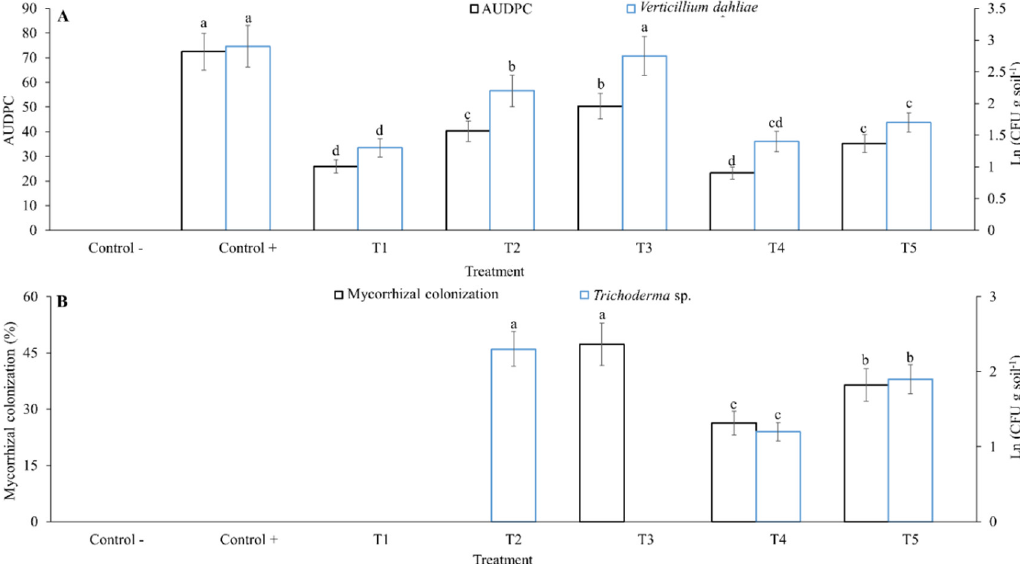
Figure 3. Effect of management practices of Verticillium dahliae in Hass avocado under net-house conditions on beneficial population of soil microorganism and reduction of AUDPC. ( A ): area under disease progress curve (AUDPC) of wilt disease under different treatments. ( B ): mycorrhizal colonization and inoculum of Trichoderma sp. quantified under different treatments for wilt disease. Error bars represent the confidence interval of the mean, validated by Tukey mean separation test. Equal letters indicate that there are no significant differences ( p > 0.05). Treatments were (where “nh” stands for net-house conditions): a non-inoculated control of healthy plants (nh—healthy control); a control of plants inoculated with V . dahliae (Vert 2) (nh—diseased control); T1nh (fungicide): Verticillium -inoculated plants + benomyl; T2nh (Tricho- derma): Verticillium -inoculated plants + inoculation with Trichoderma sp.; T3nh (mycorrhiza): Verticillium -inoculated plants + inoculation with R . fasciculatum ; T4nh (fungicide-Trichoderma-mycorrhiza): Verticillium -inoculated plants + simultane- ous application of T1nh+T2nh+T3nh; and T5nh (Trichoderma-mycorrhiza): Verticillium -inoculated plants + simultaneous application of T2nh+T3nh.